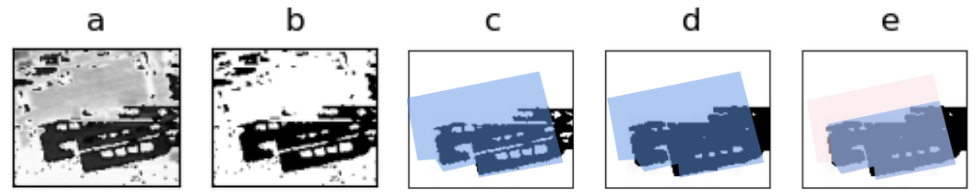
Figure 9. Mask refinement and contour segmentation of podium building. ( a ) gray difference map after last pass matching; ( b ) binarization of gray difference map; ( c ) new mask after connectivity analysis; ( d ) refined mask after morphological filtering ( e ) polygon of sub roof